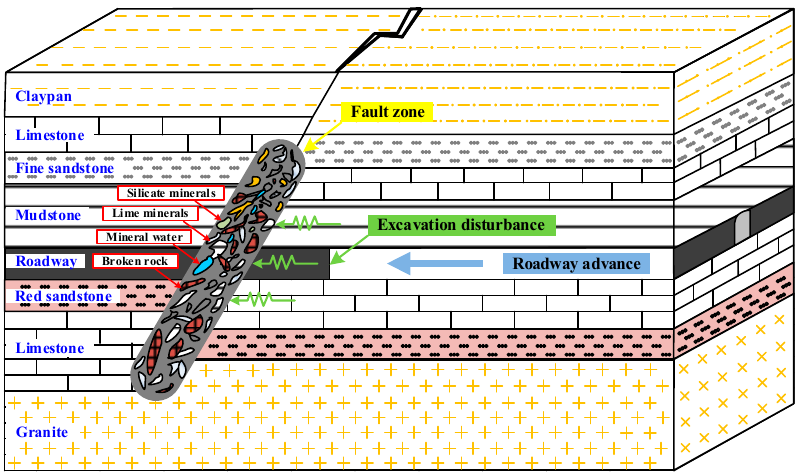
Figure 1. Cemented rock strata in fault zone: excavation for a roadway is shown, with an example of possible adjacent layering.